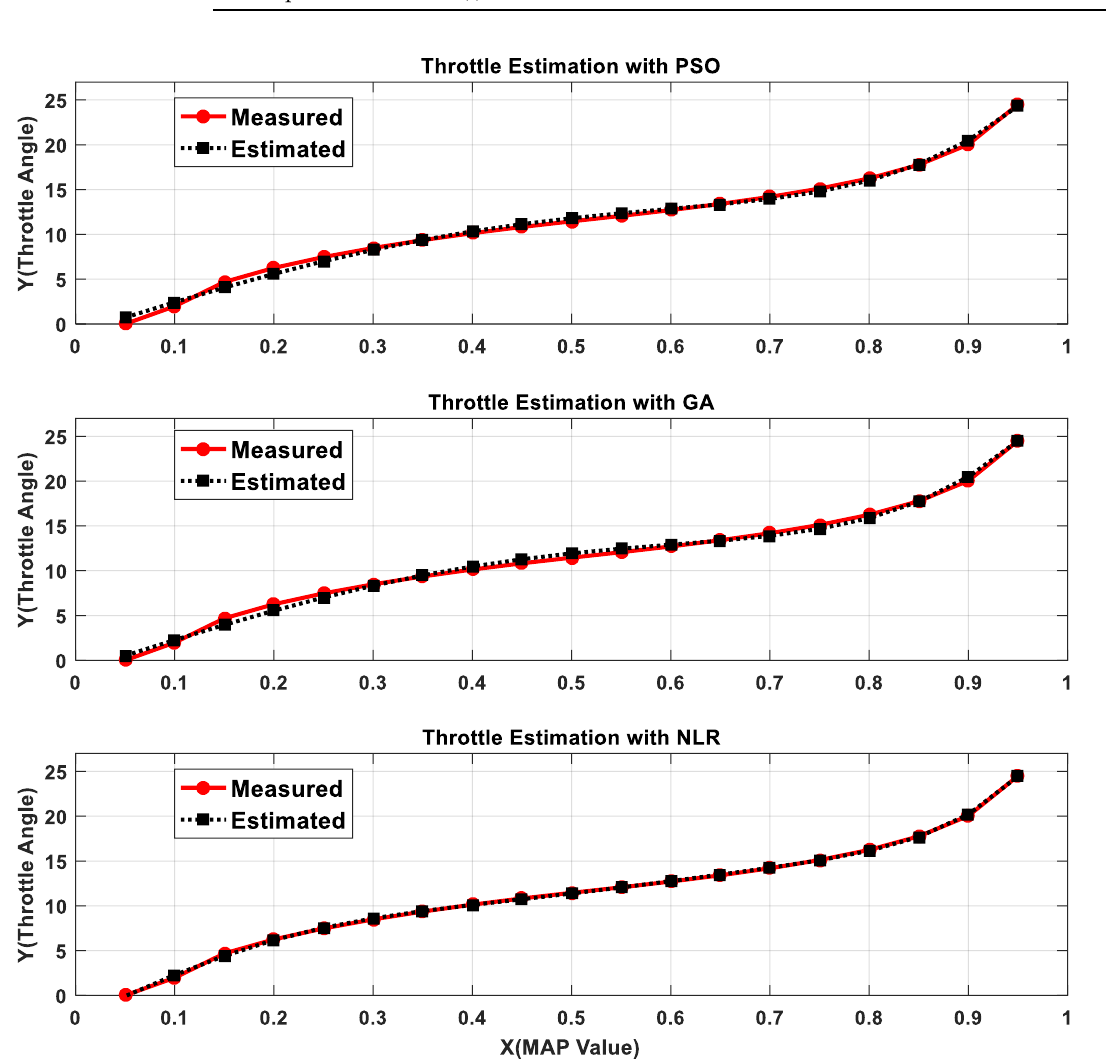
Figure 5. Estimated throttle values with PSO, GA, and NLR.